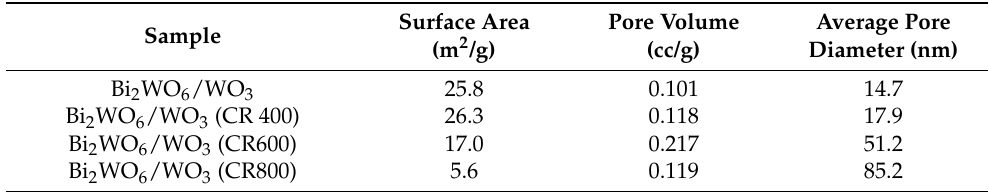
Table 3. Texture properties of the Bi 2 WO 6 /WO 3 samples before and after photohydrothermal treatment.